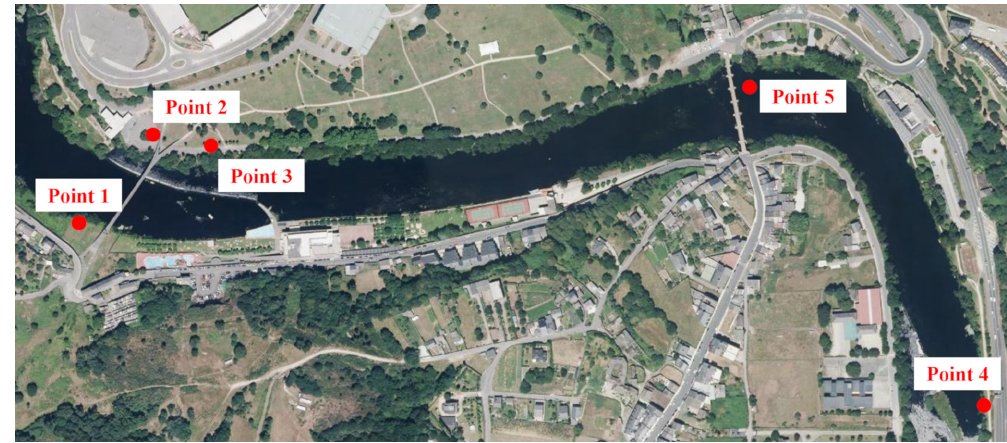
Figure 6. Location of the five control points at the area of study in Lugo (PNOA courtesy of © Instituto Geográfico Nacional).